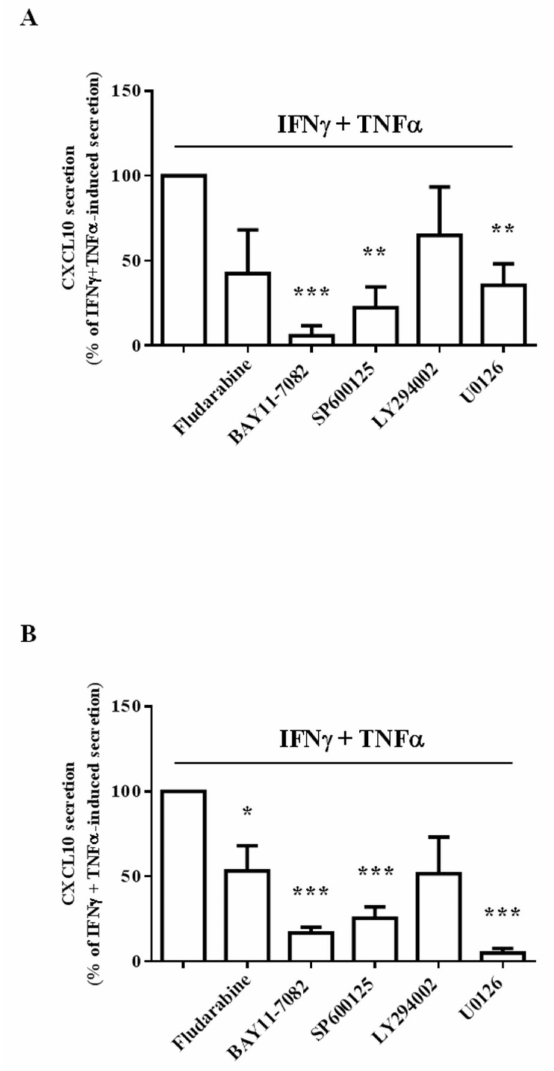
Figure 3. Different intracellular path engagement in CXCL10 protein release by human